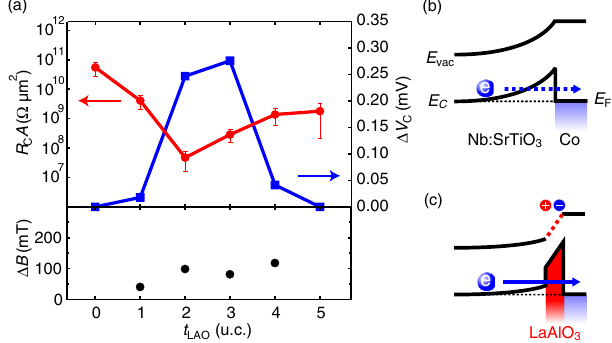
FIG. 2. Tuning charge and spin transport via artificial dipoles. (a) Top panel: Comparison of the junction zero-bias contact A ) (left axis, red circles) with Δ V resistance-area product ( R C C ¼ 0 . 4 V as a function (right axis, blue squares) measured at V C of t . Bottom panel: Linewidths of the Lorentzian MR. (b),(c) LAO Interface energy band diagrams illustrating the decrease of the Schottky barrier height and depletion width by the insertion of an interface dipole in the form of a single unit cell of LaAlO 3 ð 001 Þ